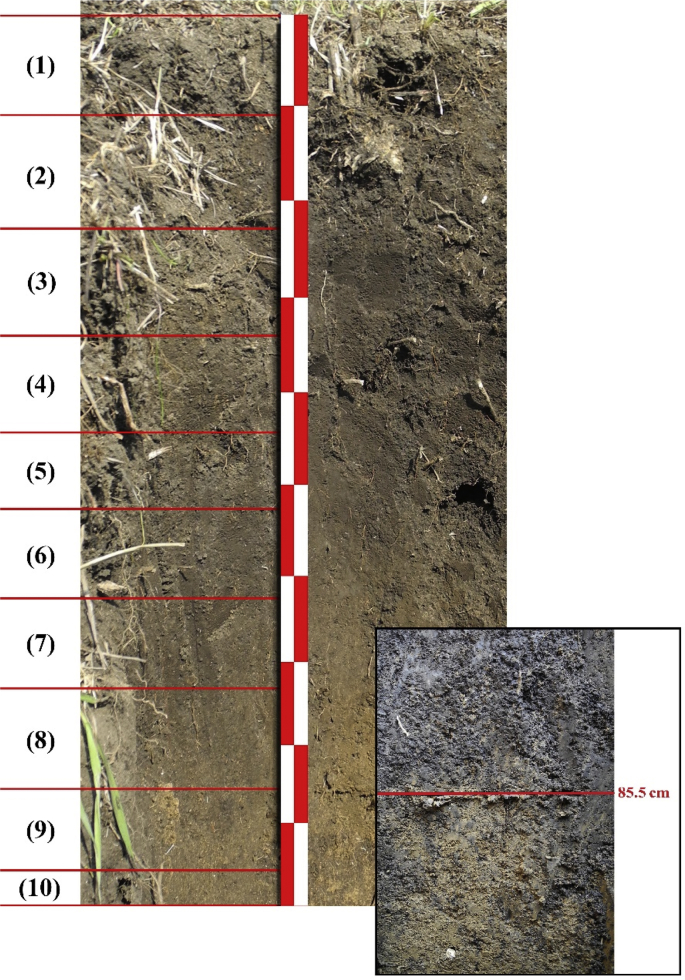
New (2019) vertical profile of pedosediments and their lower border at a depth of 85.5 cm. Layer numbers correspond to the depths: 0–11, 11–23, 23–34, 34–44, 44–52.5, 52.5–62.5, 62.5–73, 73–85.5, 85.5–96, 96–100 cm.